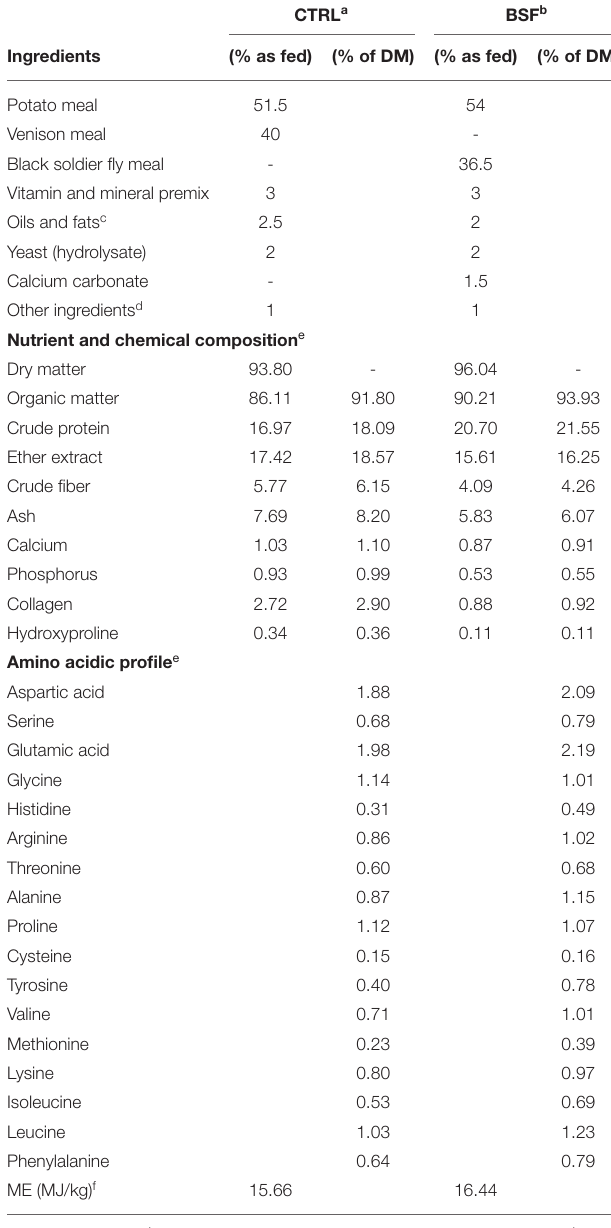
any uneaten food was weighed and recorded. Feces were TABLE 1 | Ingredients and nutritional composition of the experimental diets. CTRL a